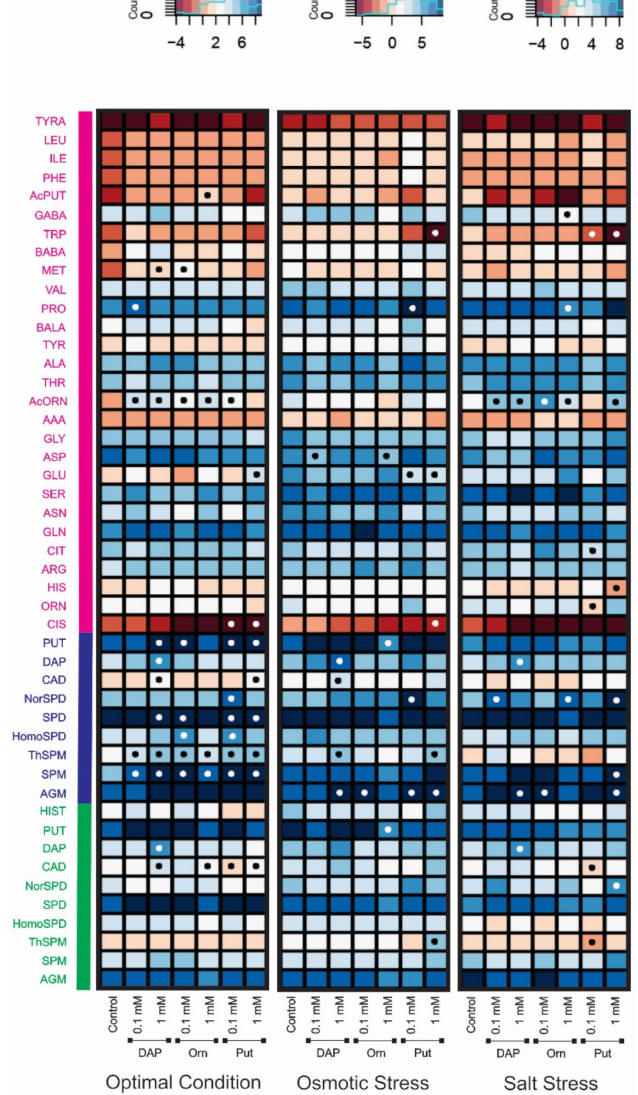
Figure 3. Metabolic profile of free amino acids (pink) [tyramine (TYRA), leucine (LEU), ileucine (ILE), phenylalanine (PHE), N-acetylputrescine (AcPUT), γ -aminobutyric acid (GABA), tryptophan (TRP), β - aminobutyric acid (BABA), methionine (MET), valine (VAL), proline (PRO), β -alanine (BALA), tyrosine (TYR), alanine (ALA), threonine (TRH), N-acetylornithine (AcORN), 2-aminoadipic acid (AAA), glycine (GLY), aspartic acid (ASP), glutamate (GLU), serine (SER), asparagine (ASN), glutamine (GLN), citruline (CIT), arginine (ARG), histidine (HIS), ornithine (ORN), cystine (CIS)], total polyamines (blue) [putrescine (PUT), 1,3-diaminopropane (DAP), cadaverine (CAD), norspermidine (NorSPD), spermidine (SPD), homospermidine (HomoSPD), thermospermine (ThSPM), spermine (SPM), agmatine (AGM)], and free polyamines (green) [histamine (HIST), PUT, DAP, CAD, NorSPD, SPD, HomoSPD, ThSPM, SPM, AGM] in Arabidopsis thaliana (Col-0 ecotype) seedlings from primed seeds with 1,3-diaminopropane (DAP), Ornithine (Orn), or Putrescine (Put) at two concentrations (0.1 or 1 mM) grown under optimal conditions, osmotic stress, and salt stress. Data were normalized through a natural logarithm. Each cell represents the values of four biological replicates ( n = 4). Red and blue colors indicate a decrease and increase, respectively, for the level of each metabolite. Mean values containing black or white points show significant differences among treatments evaluated by Tukey’s test ( p <